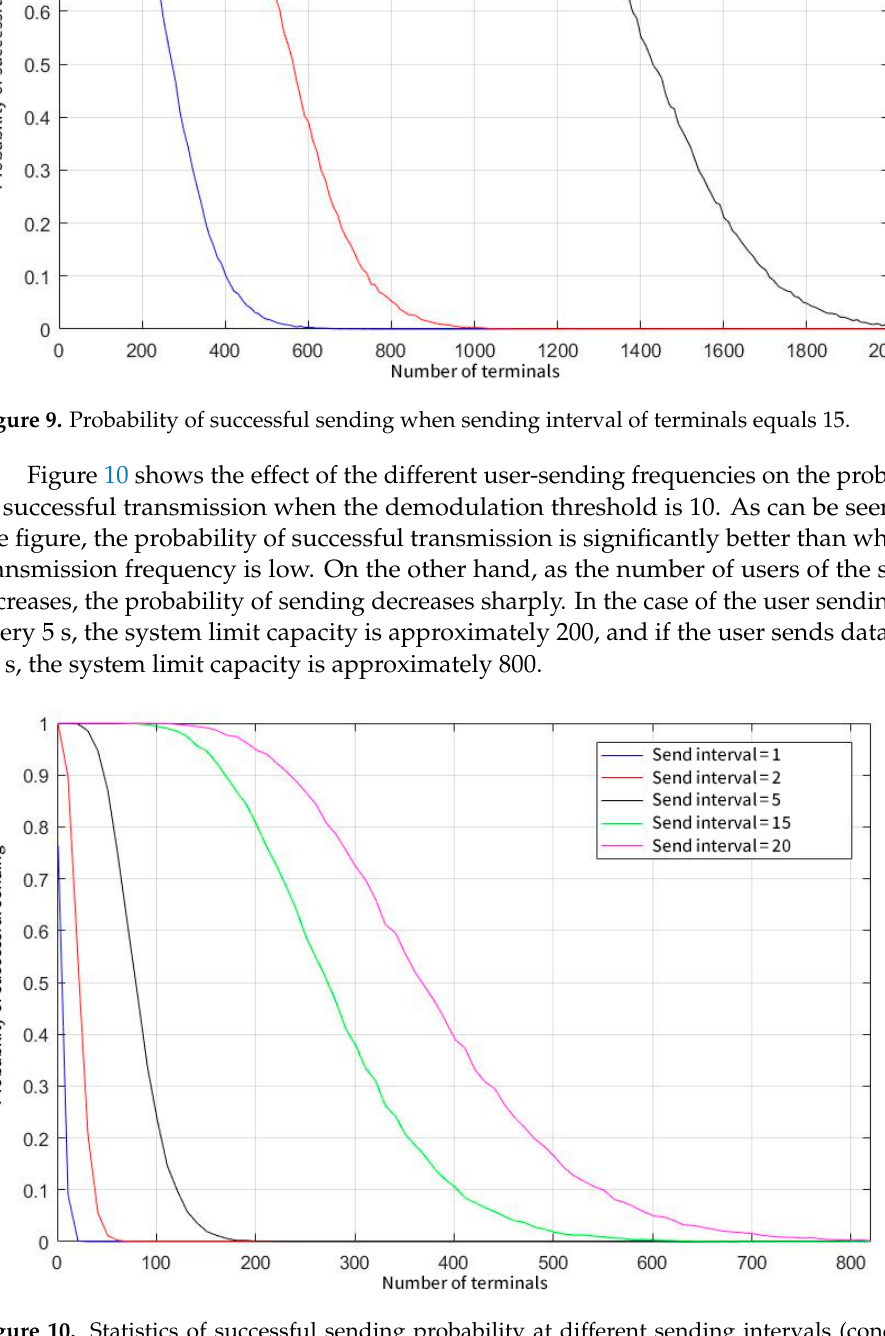
Figure 8. Probability of successful sending when sending interval of terminals equals 1.